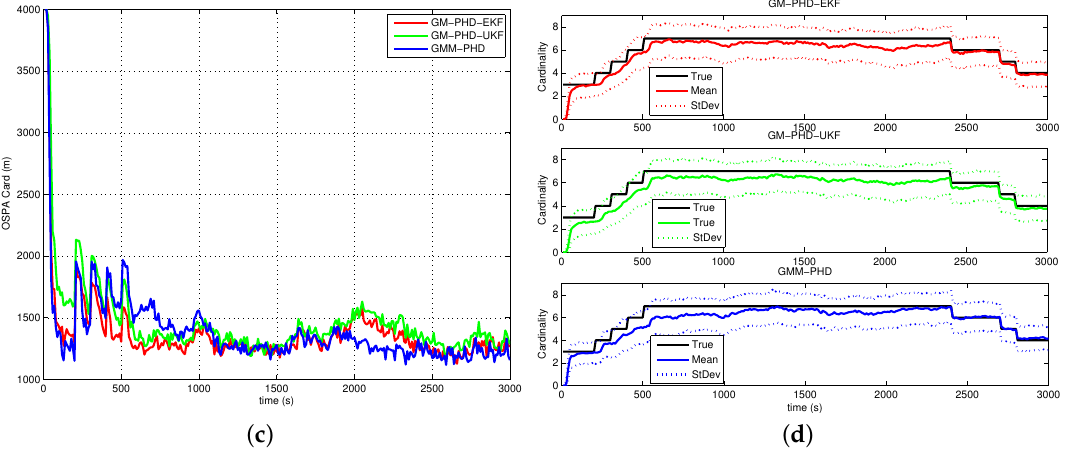
Figure 8. Results of Case 4: ( a ) OSPA distance; ( b ) OSPA localization; ( c ) OSPA cardinality; ( d ) Cardinality statistics.